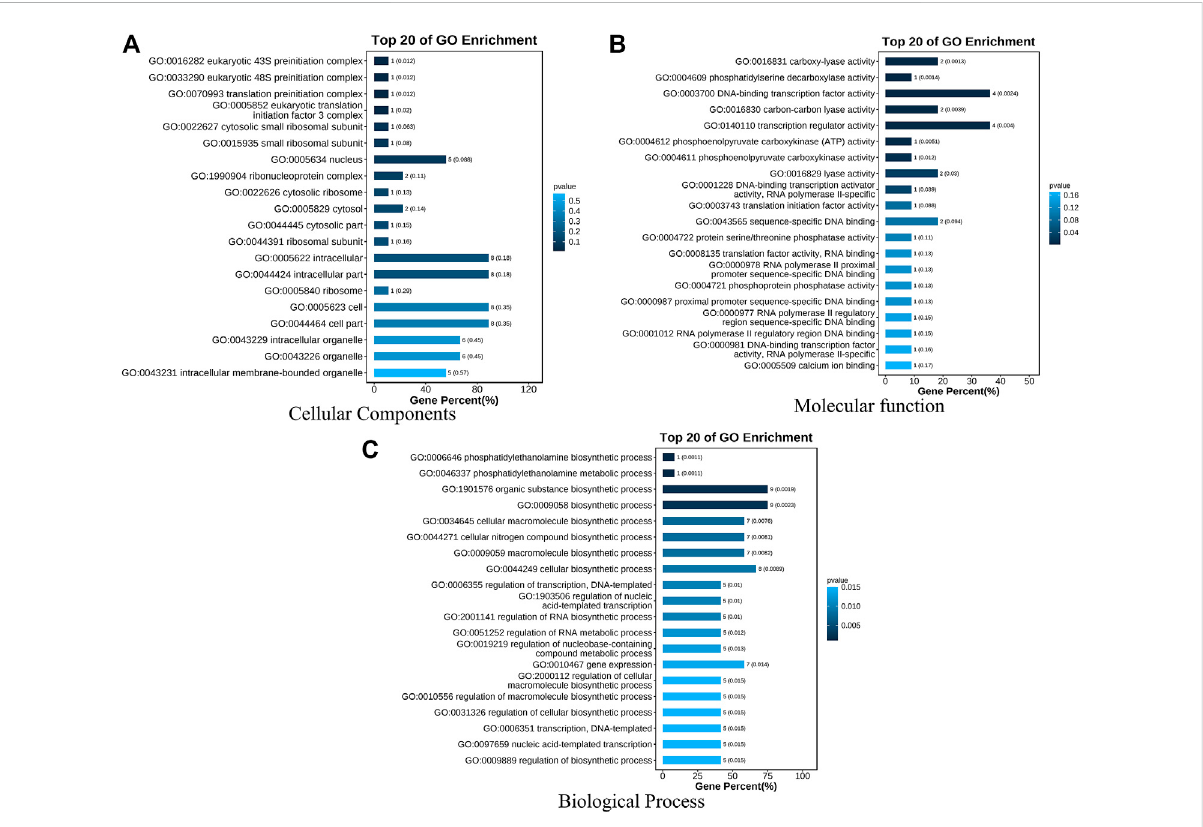
FIGURE 4 GO enrichment analysis of seventeen genes within seven co-localized QTLs. Three GO Ontologies are shown (A) Cellular Component; (B) Molecular Function, and (C) Biological